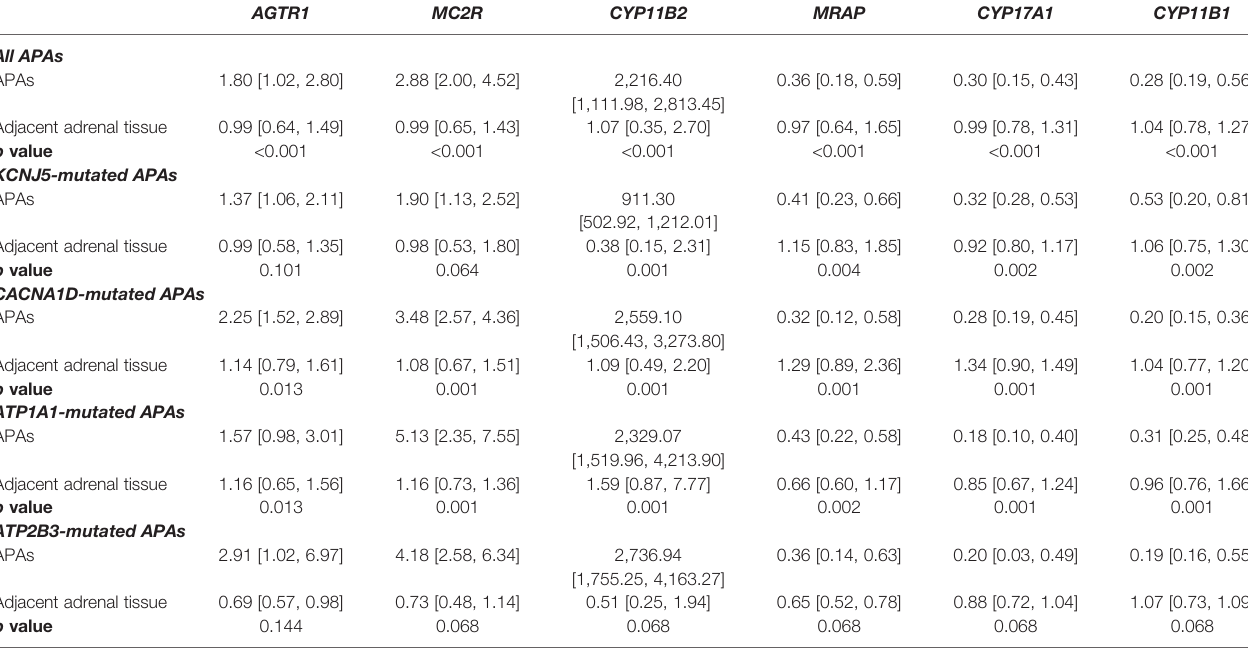
TABLE 2 | Paired comparisons of transcript levels of AGTR1 , MC2R , MRAP , and steroidogenic enzymes between APAs and adjacent normal adrenal